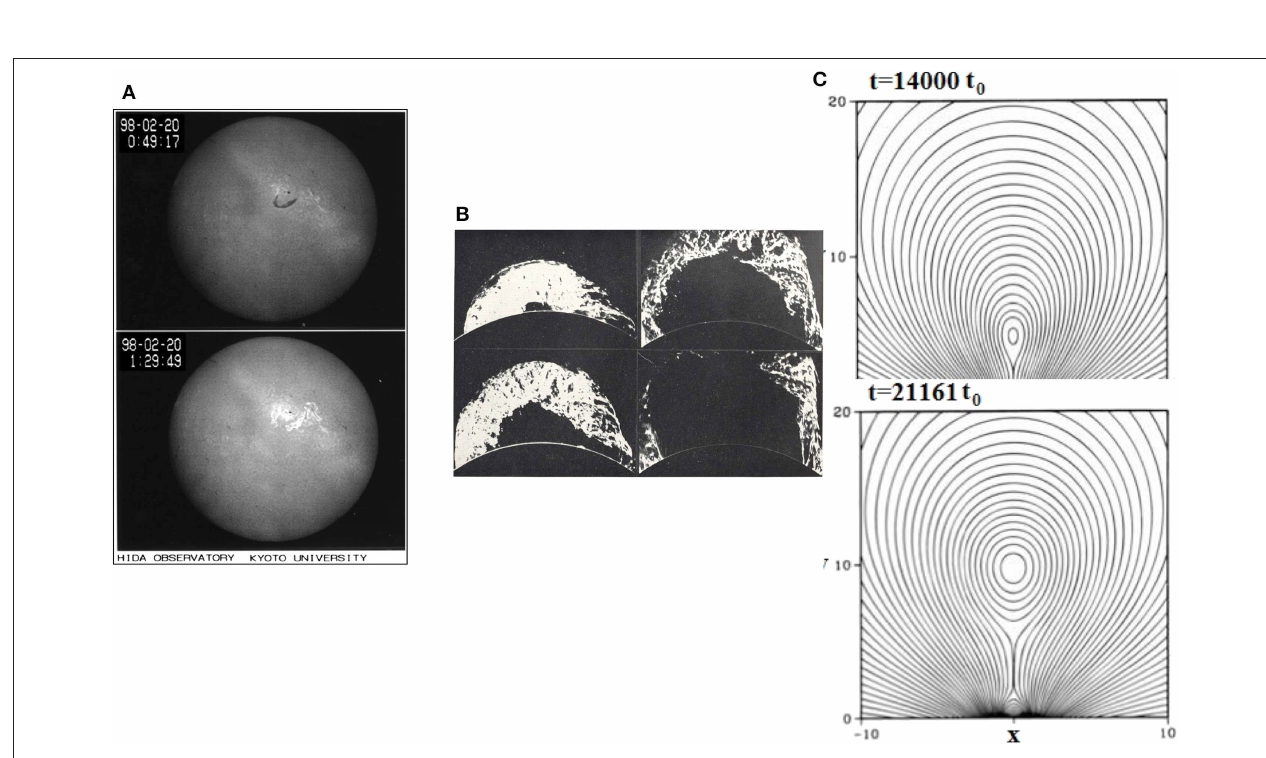
FIGURE 13 | Explosive features of flares. (A) The dark filament explodes at about the time of the H α emission enhancement. This phenomenon is known as “disparition brusque” (courtesy of the Norikura Solar Observatory, E. Hiei). (B) An example of rising prominences (the High Altitude Observatory, courtesy of W. O. Roberts). (C) A simulation of the exploding dark filament (Choe and Lee, 1996a,b; Akasofu and Lee, 2019).